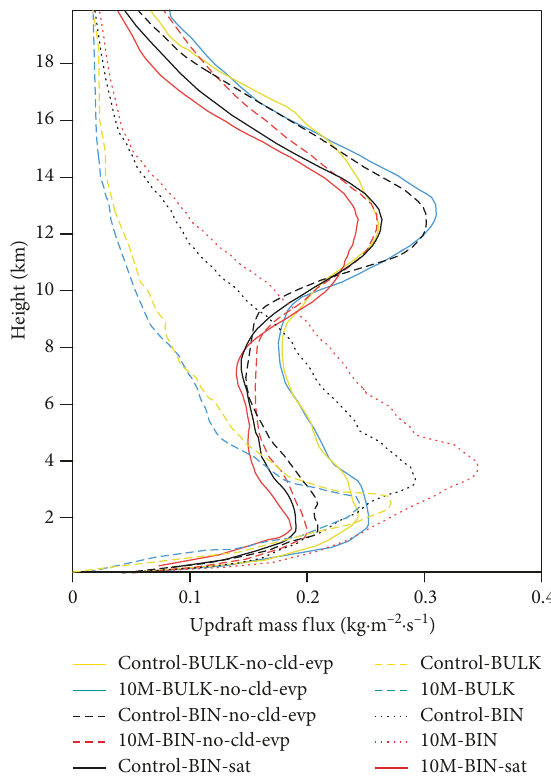
Figure 8: Vertical distributions of the time- and domain-averaged updraft mass fluxes for the simulations in Figure 7(b), the control- BIN-sat run, and the 10M-BIN-sat